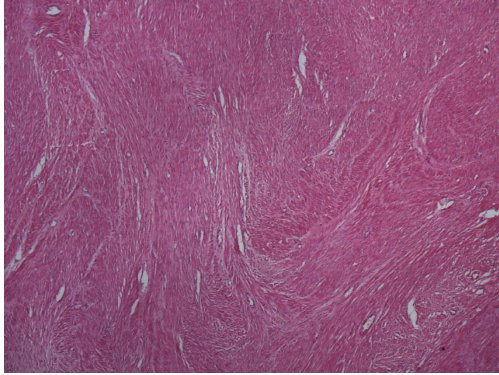
Figure 3: Histopathological